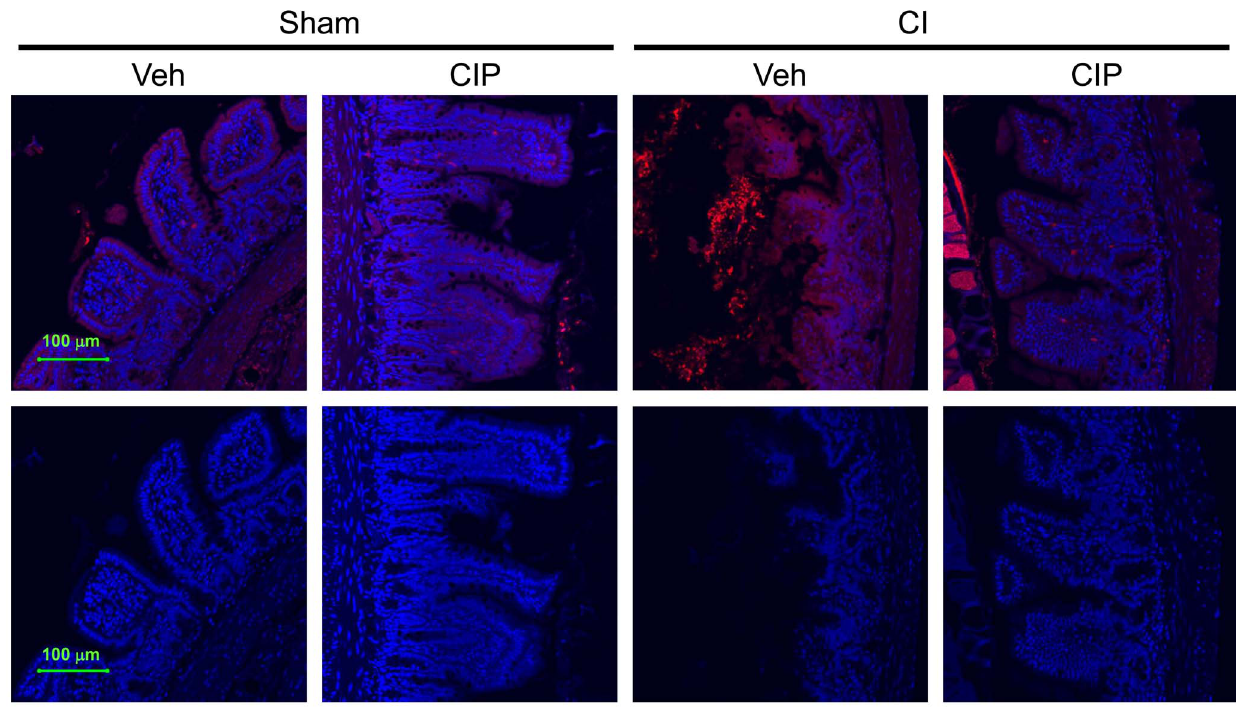
Figure 9. CIP inhibited the CI-induced increase in IgA expression after CI. On day 10 after CI, ileal samples were collected from surviving mice and prepared for immunofluorescent staining on paraffin sections. IgA expression was detected (red) with counterstaining with nucleus (blue). Representative pictures are shown with their fluorescence intensities for red signals (bottom). n=4 2 5 per group. CI: combined injury; CIP: ciprofloxacin; Veh: